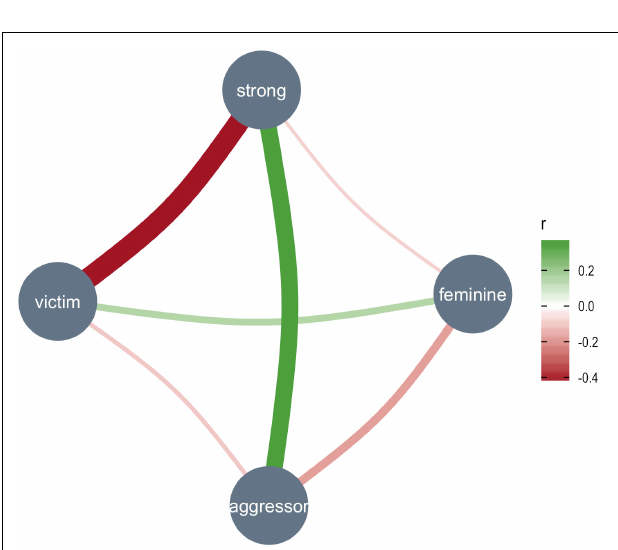
FIGURE 3 | Plot of the multilevel (partial) correlations among the judgments about the faces in the form of a Gaussian graphical model. The thickness and color of the links represent the size and direction of the partial